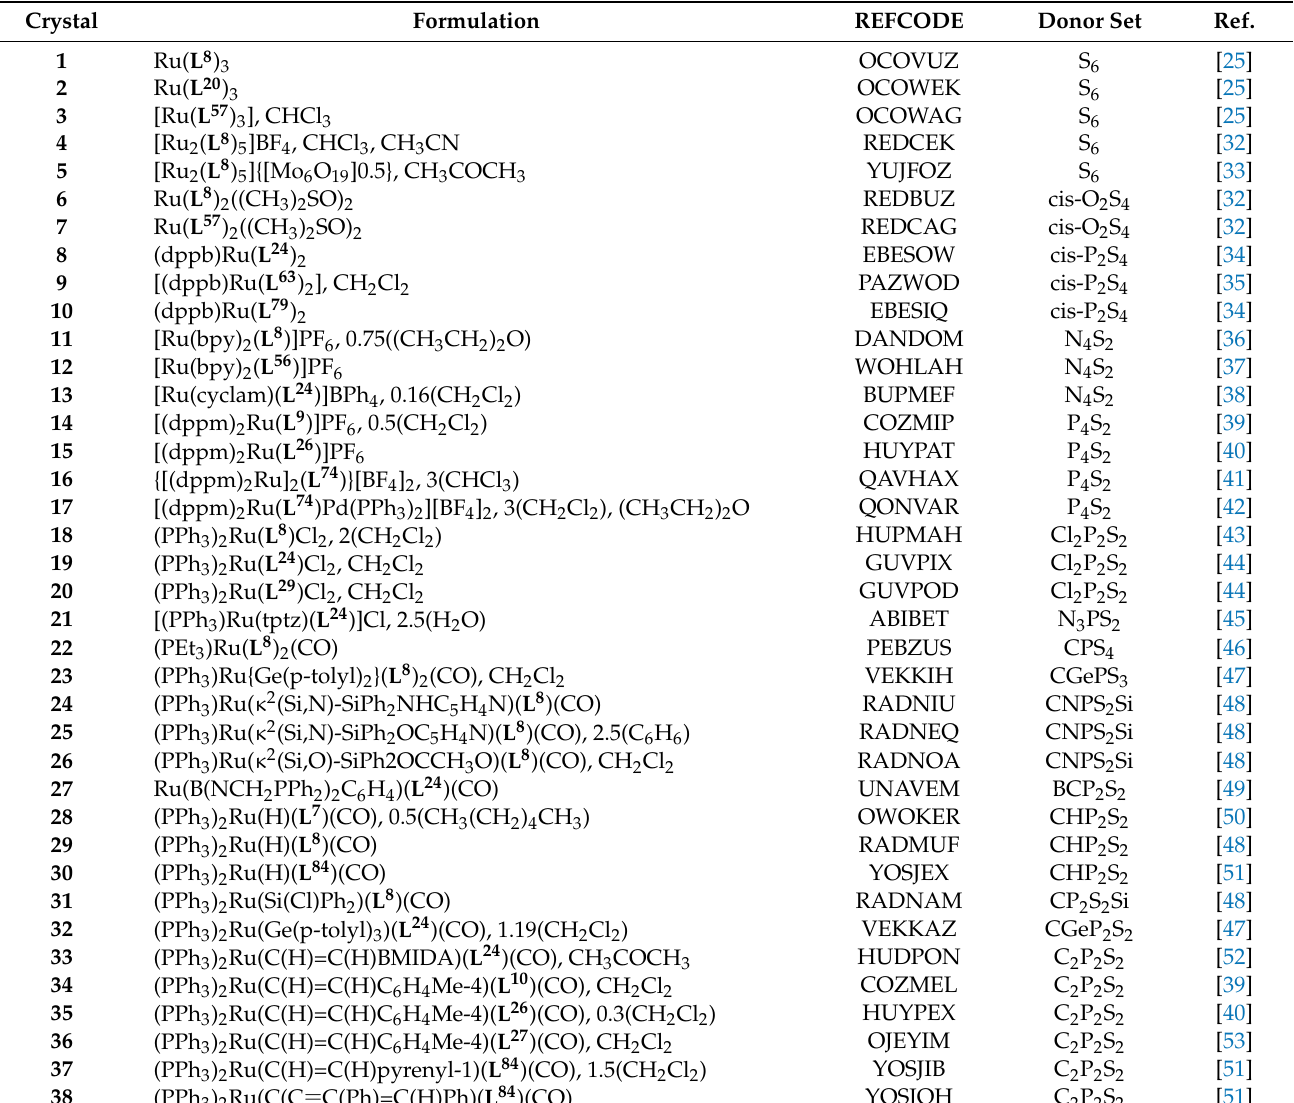
Table 2. Summary of ruthenium dithiocarbamate structures established by X-ray crystallography. See Table 1, Figure 2, and the Abbreviations